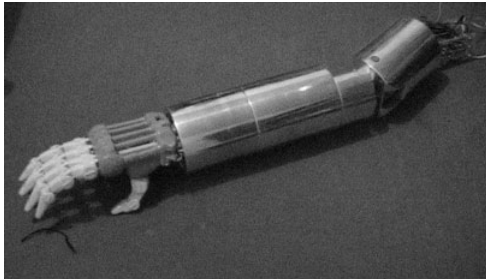
Figure 1 Prosthetic elbow.